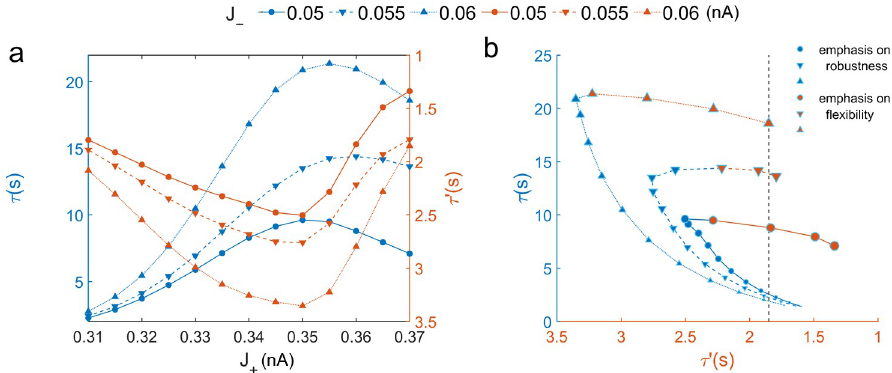
Fig 4. The relationship between the robustness against random fluctuations and the flexibility to a new stimulus. (a)The robustness against random fluctuations and flexibility to a new stimulus as functions of self-excitation J + and mutual inhibition J − . The curves marked with the circles, lower and upper triangles represent different mutual inhibition J = 0.05, 0.055, 0.06 nA , respectively. τ and τ 0 represent the MFPT in the absence and presence of a new − stimulus respectively. Larger τ indicates better robustness against random fluctuations and smaller τ 0 implies better flexibility to a new stimulus. (b)The relationship between the robustness and flexibility. The larger size of markers on each curve indicates stronger self-excitation J + . The emergence of the intermediate state(the inflection point on each curve) leads to better flexibility to a new stimulus, while the robustness against random noise might be not significantly reduced. The blue part of each curve represents that the system is in the configuration of emphasizing the robustness where strengthening the self-excitation J + enhanced the robustness against random fluctuations at the expense of reducing the flexibility to a new stimulus. The red part of each curve implies that the flexibility to a new stimulus can be enhanced without seriously reducing the robustness against the random fluctuations through strengthening J +